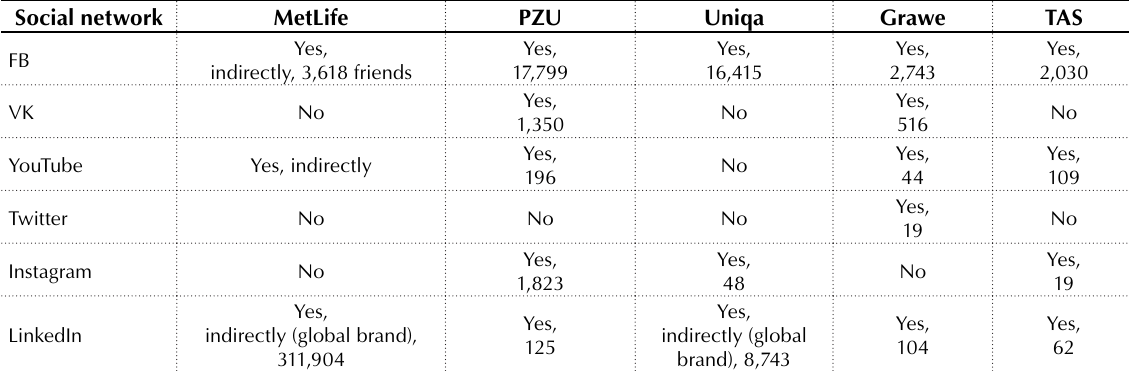
Table 5. Comparison of pages of social networks of life insurance companies in Ukraine by the number of subscribers as of November 1, 2017